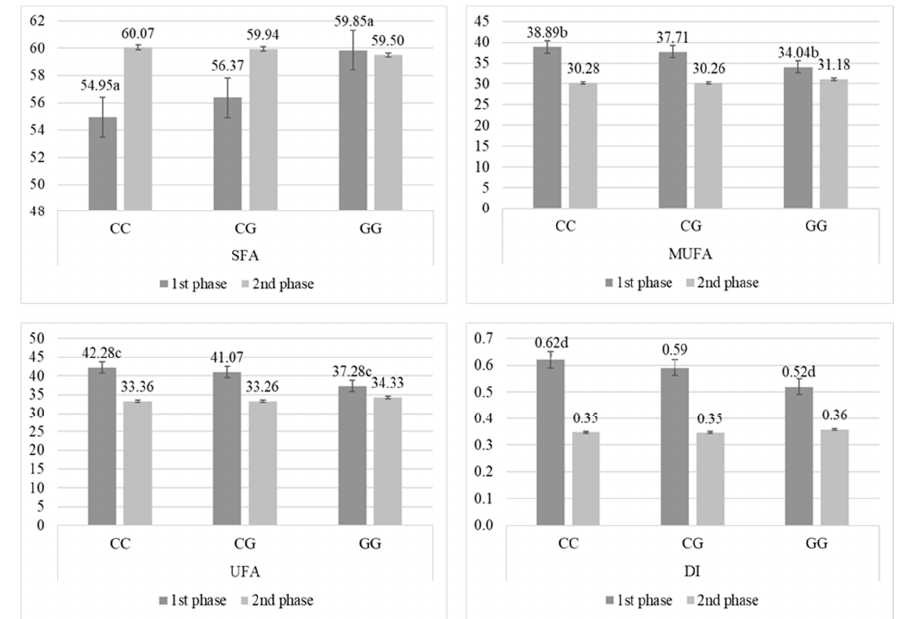
Figure 2. Percentage (mean ± SE) of saturated fatty acids (SFA), monounsaturated fatty acids (MUFA), unsaturated fatty acids (UFA), and index of desaturation (DI) in milk from Polish Holstein-Frisian cows during first and second phase of lactation depending on AJ312201.1g.1488C > G (g.1488C > G) single nucleotide polymorphism (SNP) in acetyl-CoA carboxylase α ( ACACA ) gene. a, b, c, d—values differ significantly between polymorphisms within fatty acid ( p < 0.05).